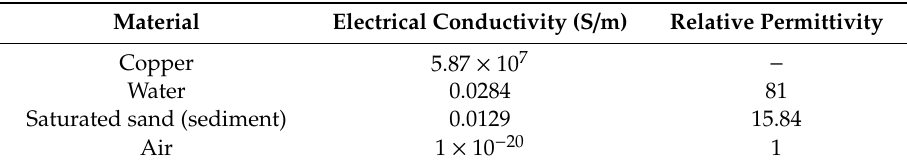
Figure 7. Meshed 3D model of the conductance sensor in COMSOL. Table 2. The electrical properties of materials used in FEA model. Table 2. The electrical properties of materials used in FEA model.